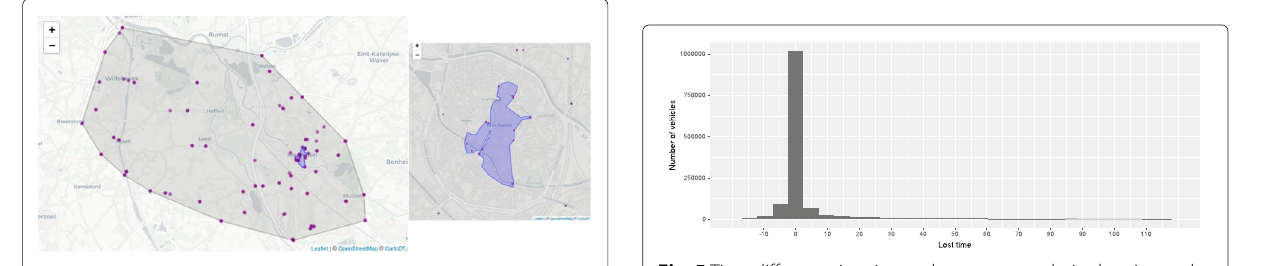
Fig. 4 Map of Mechelen-Willebroek district, Car-reduced zone and 122 ANPR